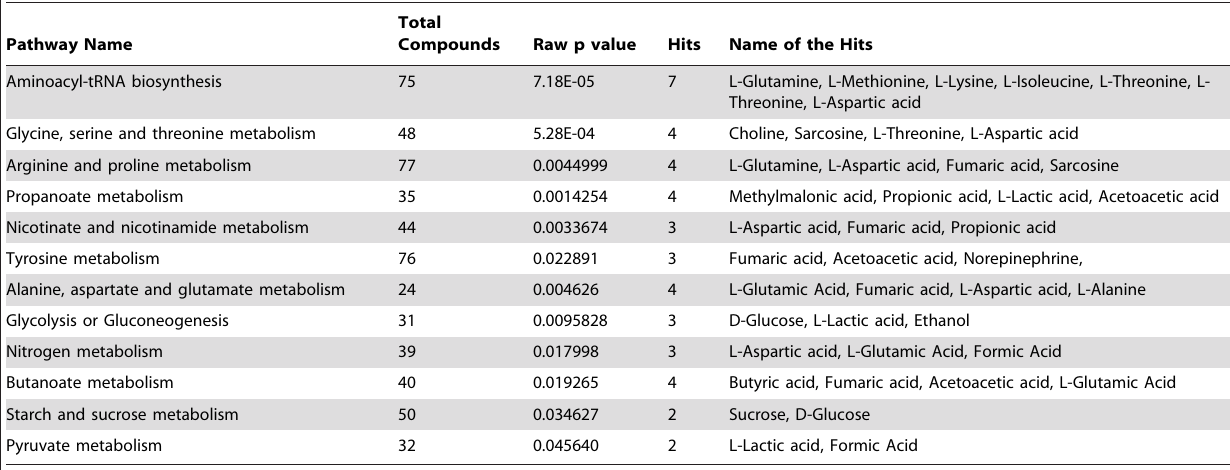
Table 3. Metabolic pathways modulated in HIV/AIDS